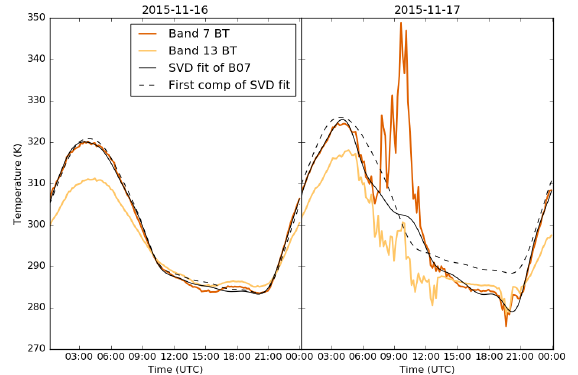
Figure 3: Robust matching algorithm results for a typical pixel (-35.2583S, 121.4374E) in the North Cascade complex fire 2015- 11-16 and 17.